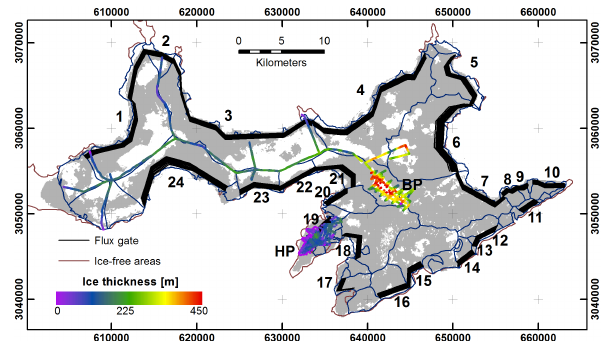
Figure 2. Livingston Island glacier basins according to Bliss et al. (2013). Numbers indicate the basins analysed in this study. Grey shading marks the area for which ice velocities could be derived from SAR data. Thick black lines denote flux gates used for com- puting ice discharge. Ice thicknesses obtained from GPR measure- ments are shown in colour. HP denotes Hurd Peninsula, and BP Bowles Plateau. The brown line indicates the coastline of the ice- free